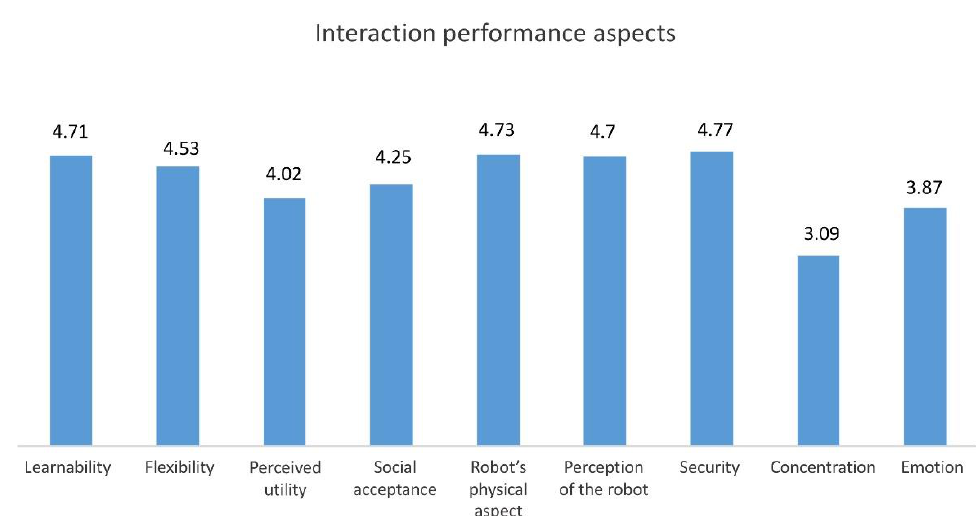
Figure 6. Evaluation scores of interaction aspects (out of /5) .